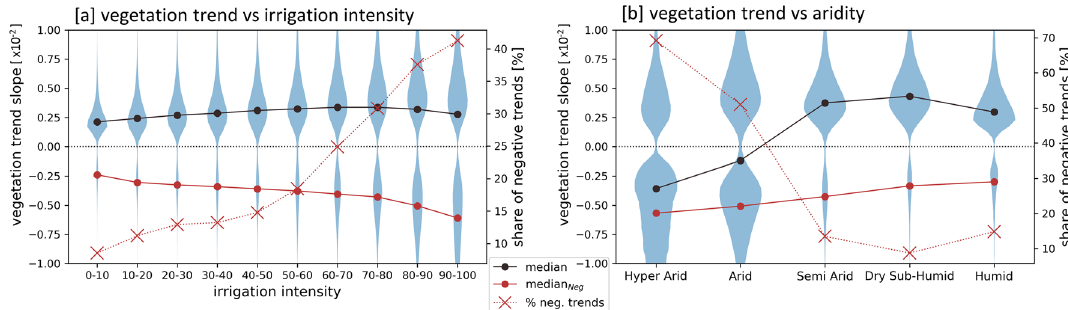
Figure 10. Vegetation growth development on agricultural areas. Trend slopes of annual vegetation growth ( NDVI MEAN ∗ ) are analyzed versus irrigation intensity ( a ) and aridity ( b ). General Notes: Only significant vegetation growth trends ( p < 0.05) are considered. Agricultural areas which were cultivated after the start of the analyzed period are excluded (Methods). Irrigation intensity of an agricultural pixel is thereby characterized at the beginning between 2001 and 2003 (Fig. 9). The analysis related to aridity focuses on rather highly irrigated areas (irrigation intensity > 50). Black dots: medians of all data points. red dots: medians of negative trends. red crosses: proportion of negative